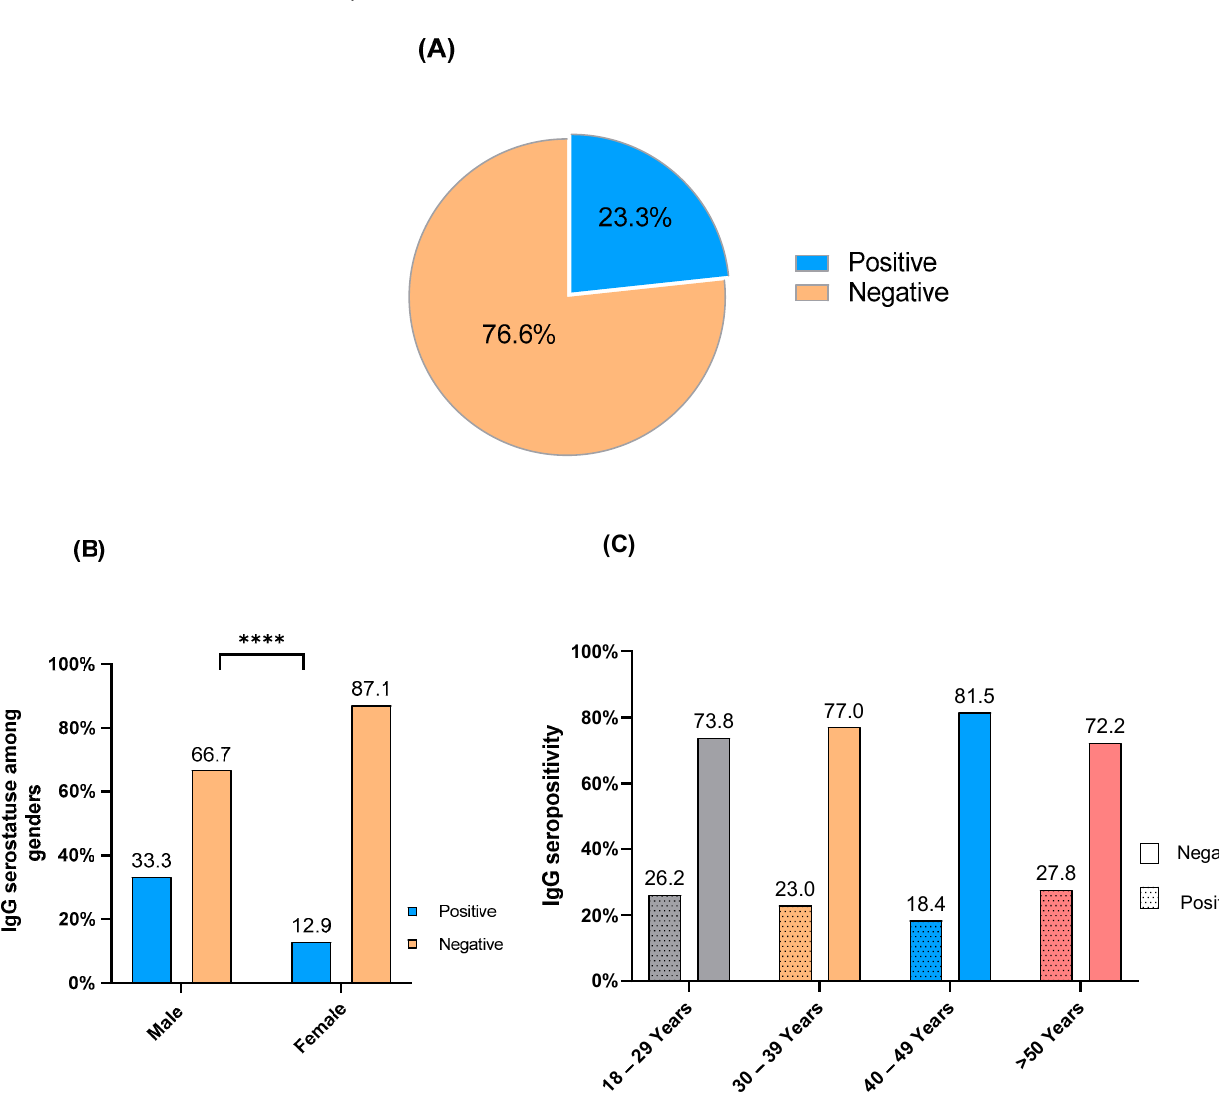
Figure 3. M. pneumoniae IgG seropositivity in the community. (A) Seroprevalence in the sample population, ( B) proportions of IgG seropositivity in different genders, ( C) distribution of IgG seropositivity for different age groups. (****) p -value < 0.0001.